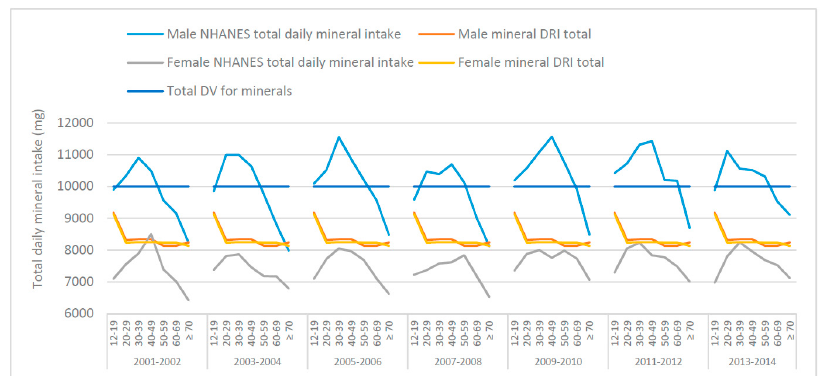
Figure 1. Total mean daily mineral intakes from food across various age groups, derived from National Health and Nutrition Examination Survey (NHANES) 2001–2014 data, the total Dietary Reference Intakes (DRI) and the total Daily Value (DV) for males and females. Because Se was the lowest value, the ratios were calculated relative to the Se intake (Se = 1). The DV ratio suggests that for every 1 mg of Se, males and females aged 50–59 years should be consuming 85,455 mg of K; 41,818 mg of Na; 23,636 mg of Ca; 22,727 mg of P; 7636 mg of Mg; 327 mg of Zn; 200 mg of Fe and 16 mg of Cu (Table 1). For the DRIs this would mean for every 1 mg of Se, males should